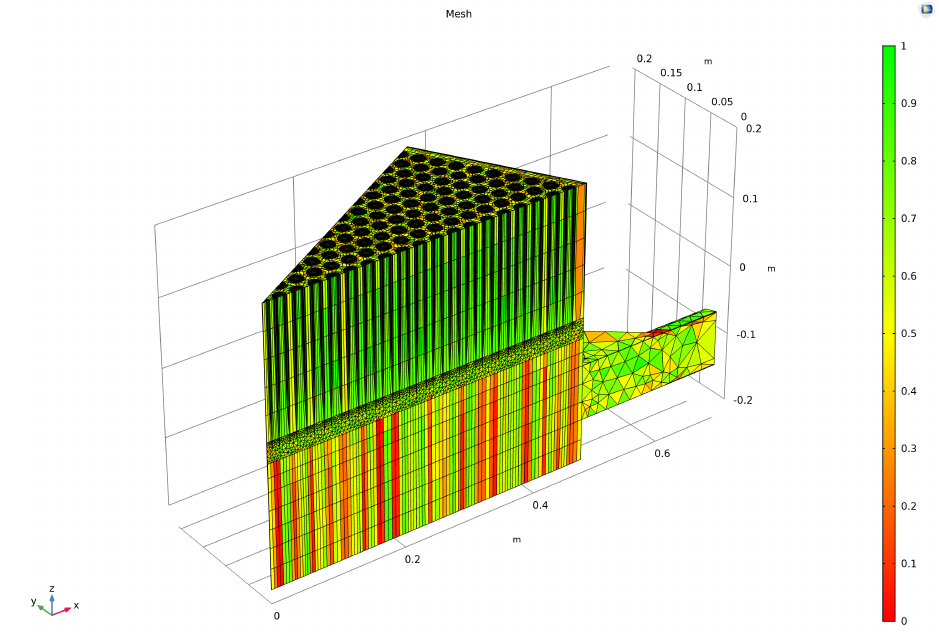
Figure 6. Mesh element quality with color indicating its value.